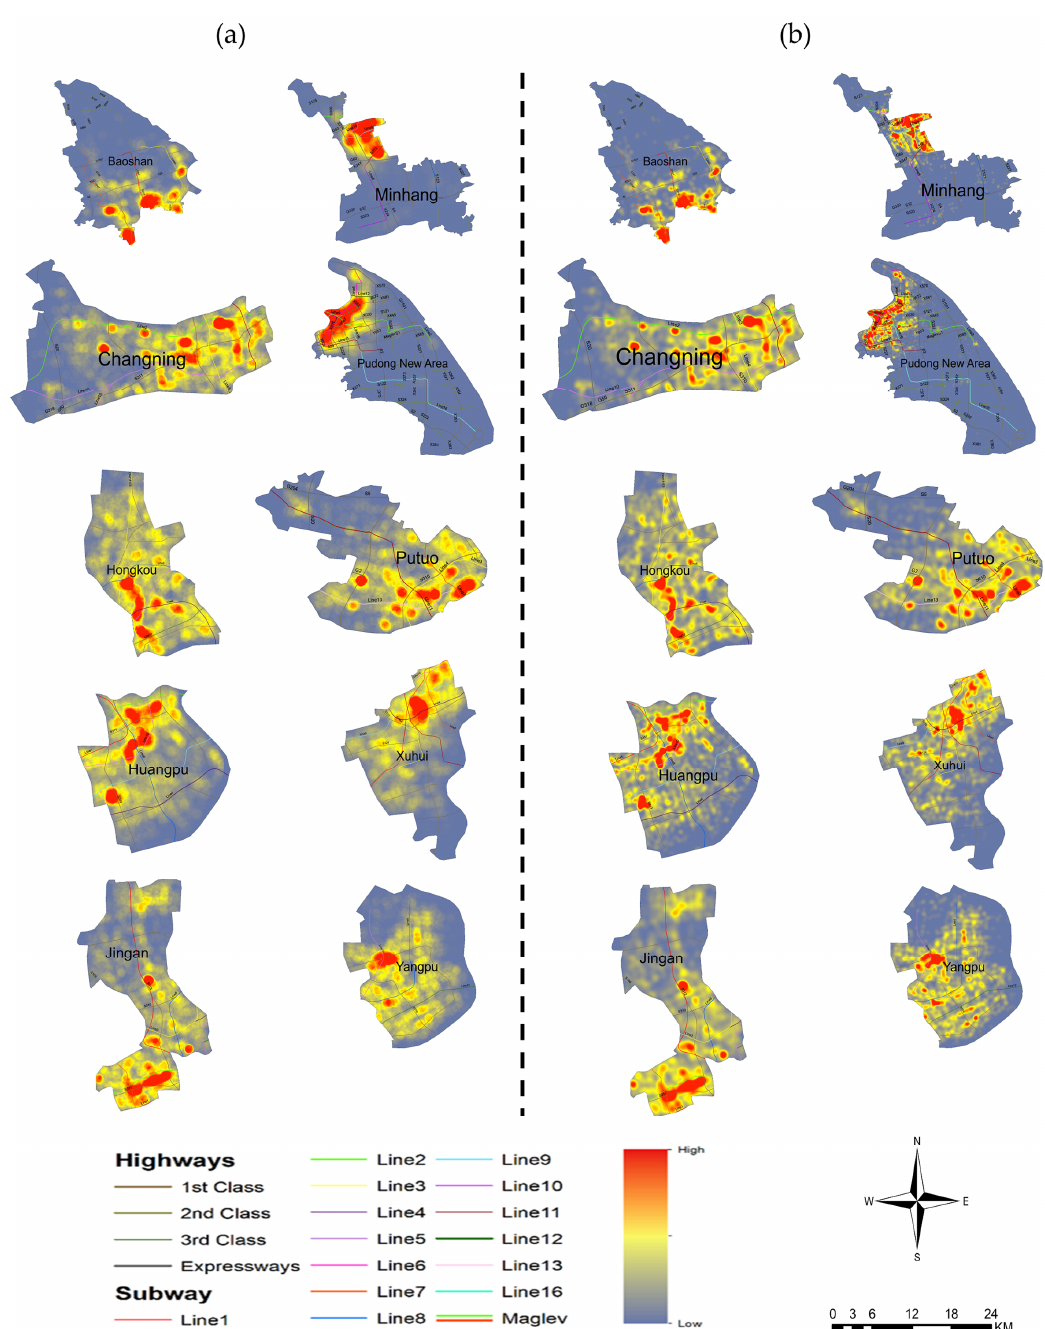
Figure 7. Check-ins distribution in the districts of Shanghai. ( a ) Point density; ( b ) kernel density.